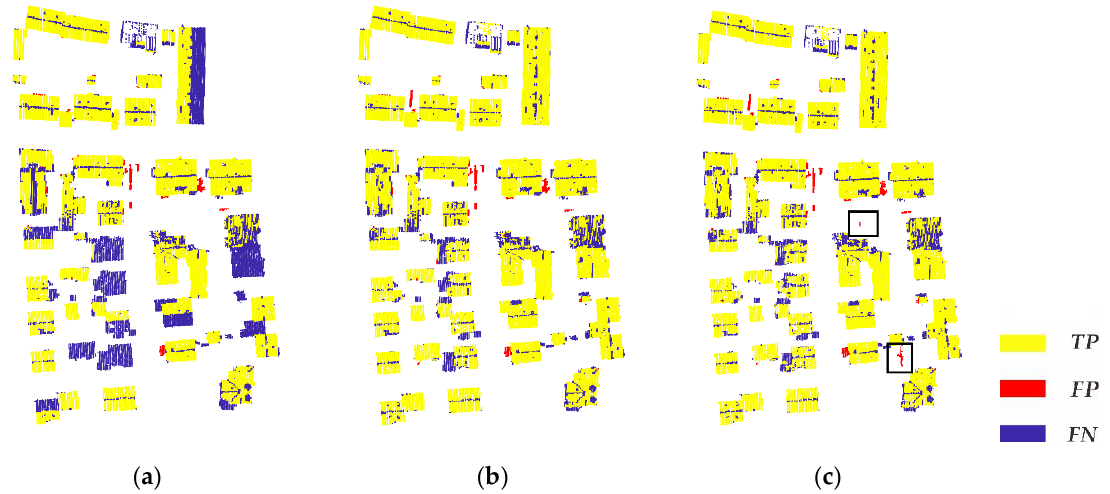
Figure 9. Initial building points extraction results with different roughness threshold. ( a ) The threshold is 0.02; ( b ) the threshold is 0.04; ( c ) the threshold is 0.06. Yellow represents correctly extracted buildings ( TP ), red represents wrongly extracted buildings ( FP ), and blue represents omitted buildings ( FN ).